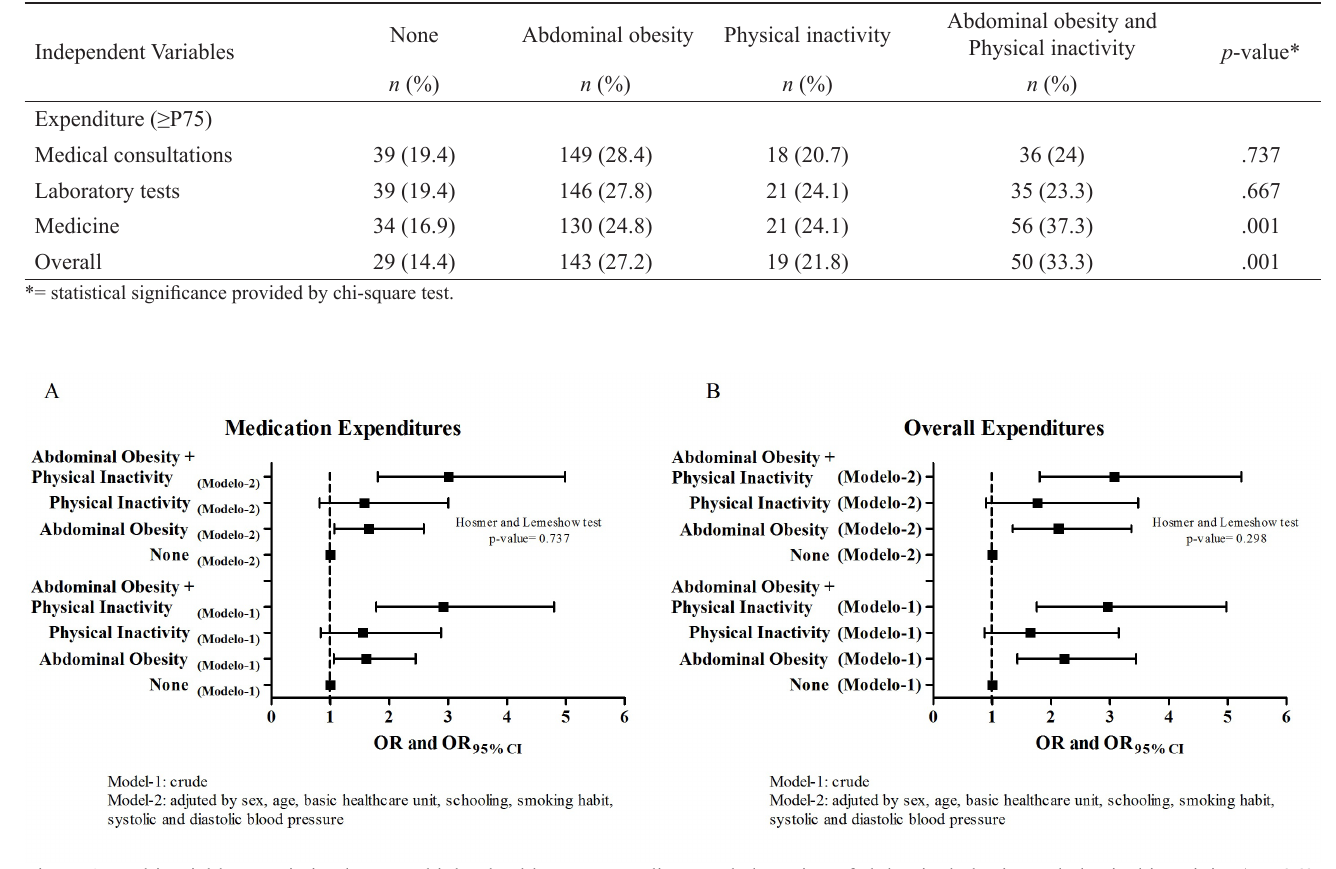
Figure 1. Multivariable association between higher health care expenditure and clustering of abdominal obesity and physical inactivity ( n = 963;